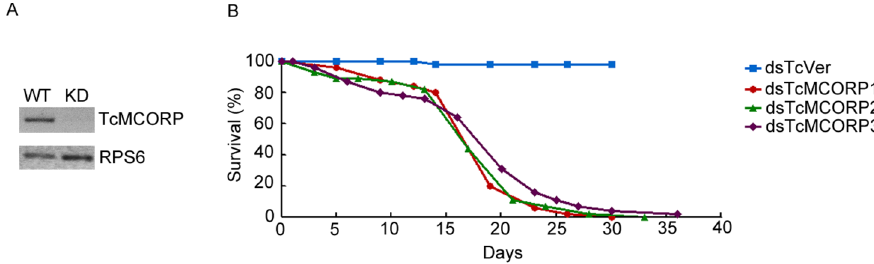
Figure 6. Efficiency of TcMCORP knockdown and effect of TcMCORP knockdown on adult life span. A) Whole bodies from WT T. castaneum pupae and from pupae with dsTcMCORP treatment (KD) 2 days post injection were analyzed. B) T. castaneum pharate pupae were injected with TcMCORP dsRNA or TcVer dsRNA. Live insects were counted starting from adult day 0. The life span of TcMCORP knockdown beetles was shorter than that of control beetles (TcVer knockdown). For TcMCORP knockdown, data are from three biological replicates (n=49, 45, or 55). For TcVer knockdown data are from one biological replicate (n=48).